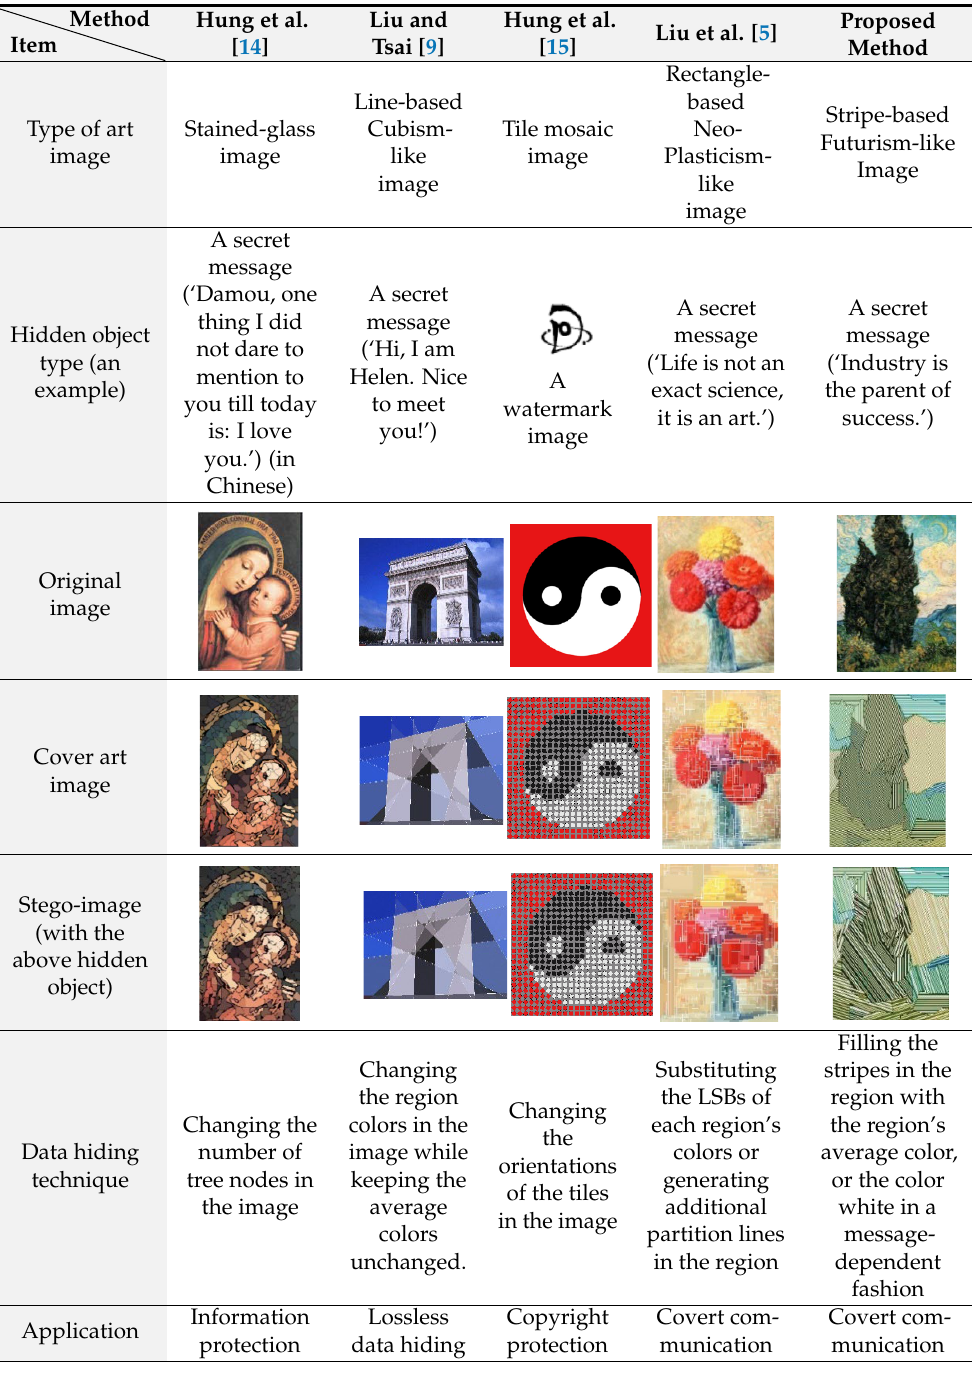
Table 5. A comparison of the proposed method with four art image generation methods with data hiding capabilities.